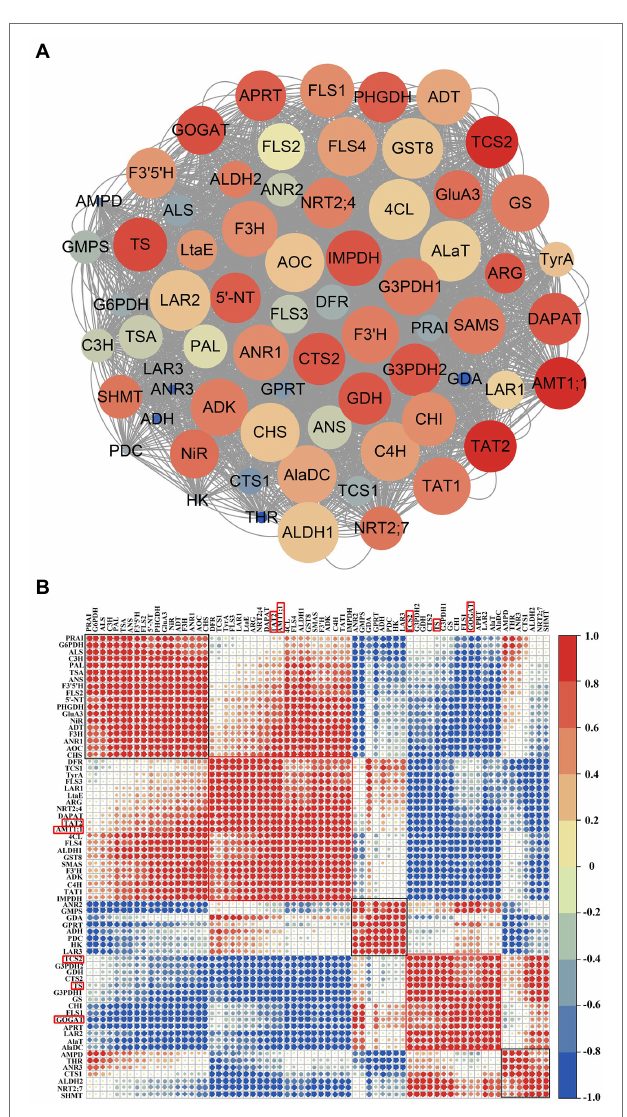
FIGURE 7 | Co-expression network and correlation analysis of genes related to nitrogen metabolism, amino acid metabolism, polyphenol metabolism, and caffeine synthesis. (A) Co-expression network visualization by Cytoscape (version 3.9.1), where genes with a high correlation coefficient are marked in “red,” and the circle size indicates the number of genes associated with central gene; (B) correlation analysis. Correlation factor ( − 1 ~ 1) indicates the correlation of two genes at the transcriptional level, with “blue” for negative correlation and “red” for positive correlation, and the larger the circle, the higher the correlation